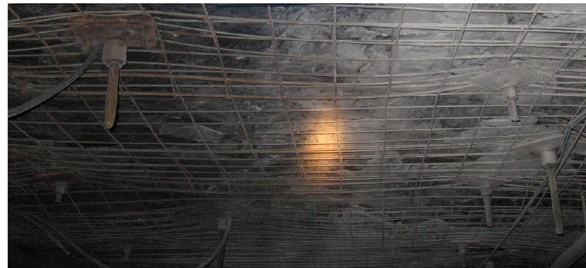
Fig. 7 Meshed roof in the trial roadway